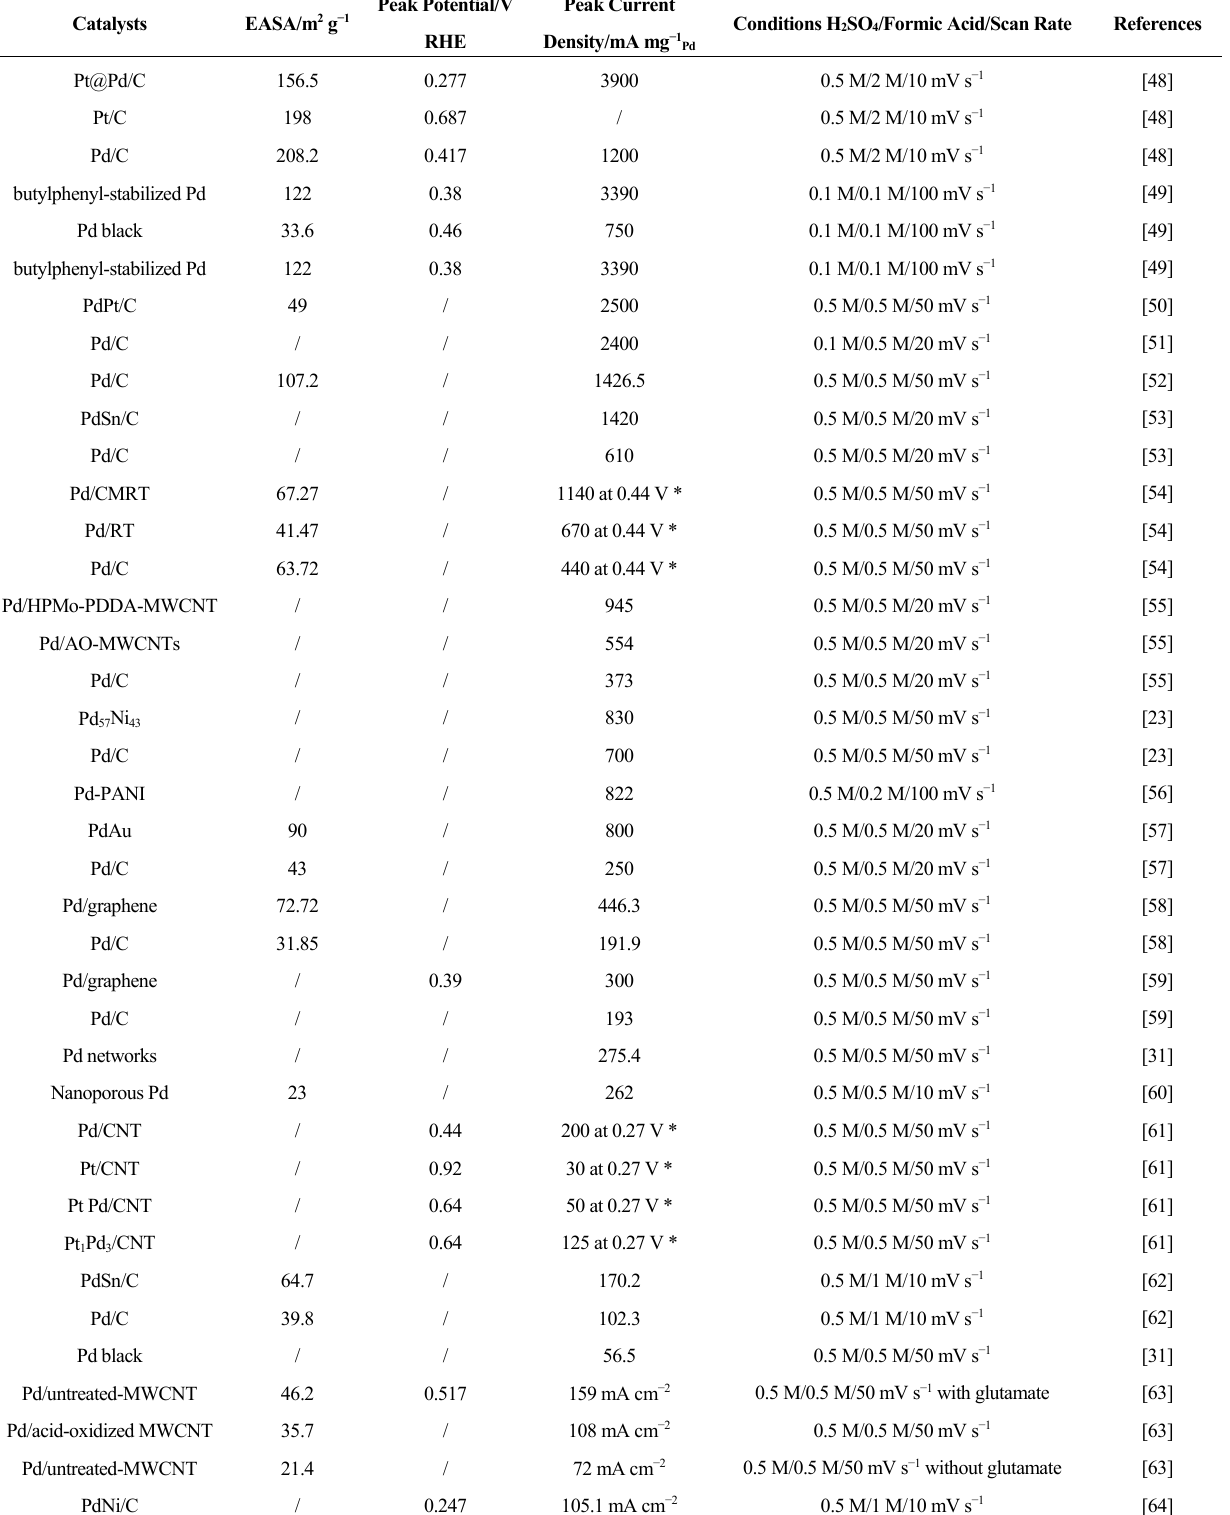
Table 1. Details of the half cell performance of the Pd-based